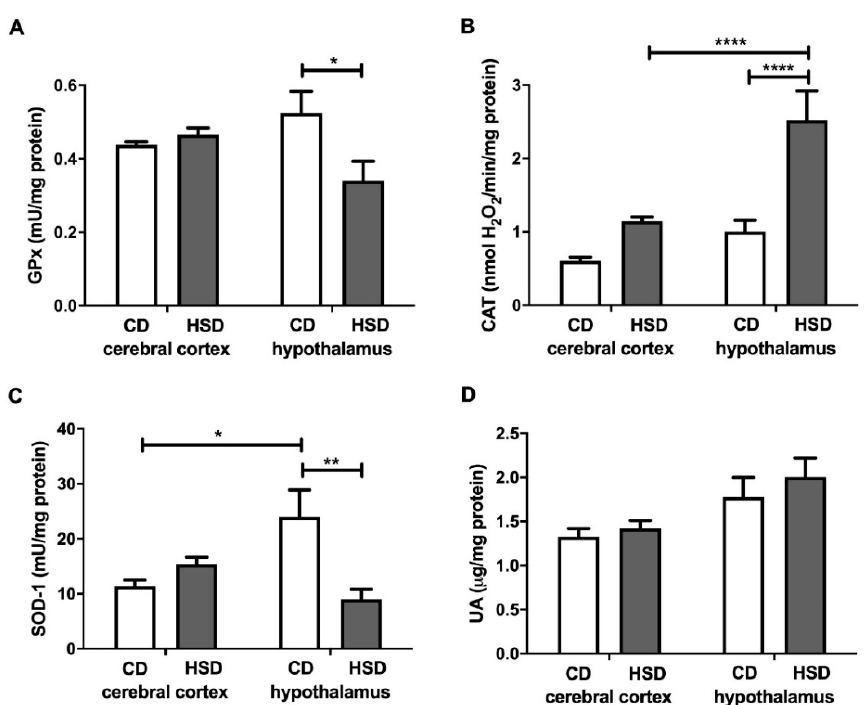
Figure 2. Enzymatic and non-enzymatic brain antioxidants (glutathione peroxidase ( A ), catalase ( B ), Cu-Zn-superoxide dismutase-1 ( C ) and uric acid ( D )) in the control and HSD-fed rats. Values are means ± SEMs; n = 10 * difference statistically significant at p < 0.05, ** p < 0.005 and **** p < 0.0001.